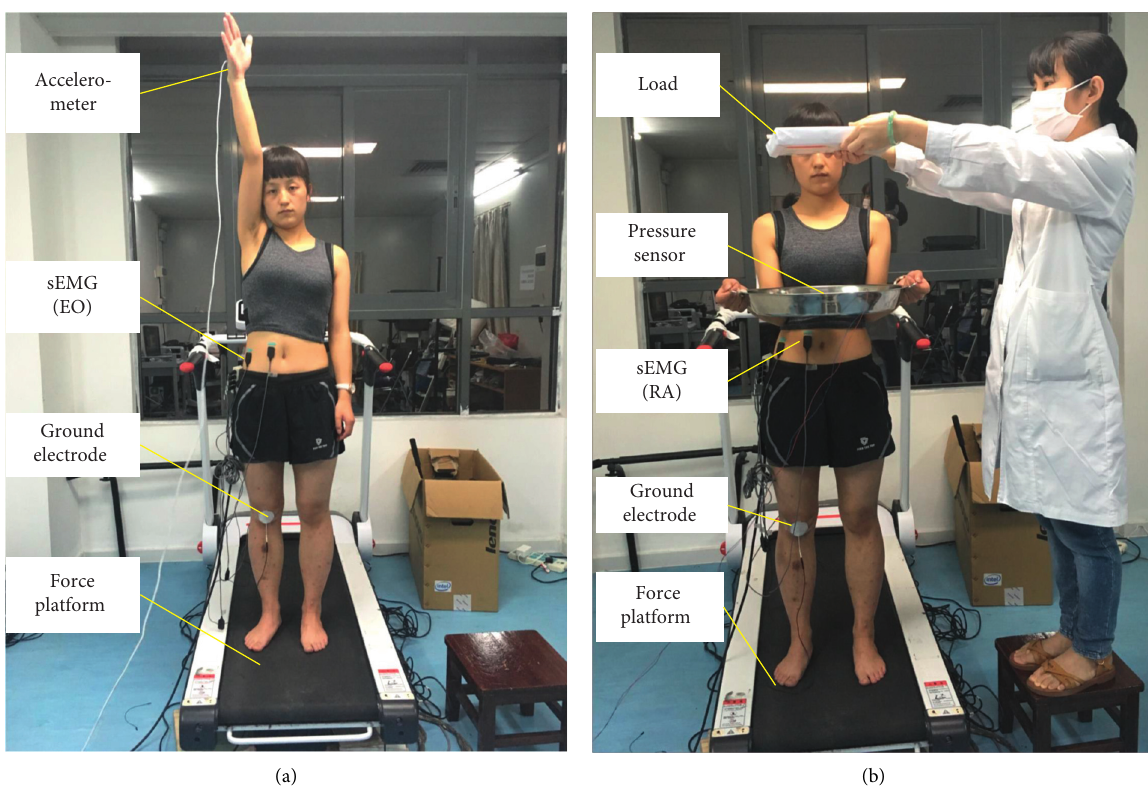
Figure 1: The experimental setup of the external and internal perturbation tasks. (a) Internal perturbation task. (b) External perturbation